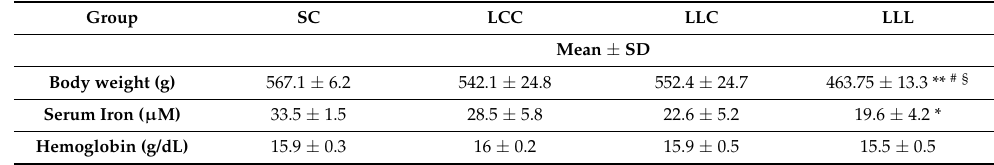
Table 2. Adult male offspring’s body weights, serum iron, and hemoglobin concentrations at 16 w/o (N = 8 in each